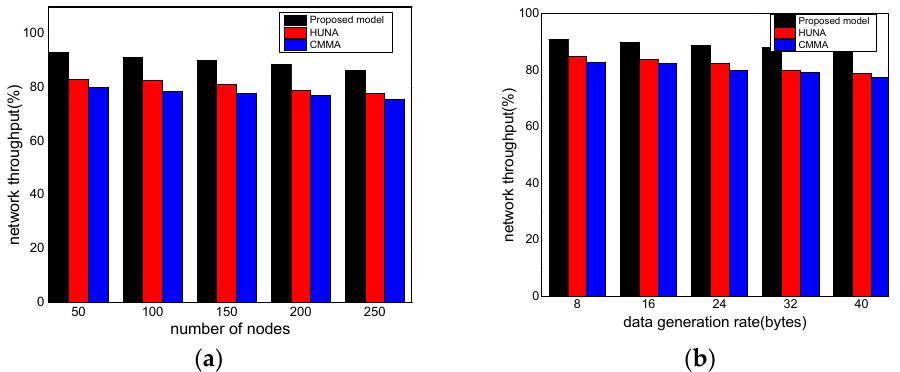
Figure 3. Performance of network throughput with the number of nodes ( a ) and packet generation rate ( b ).